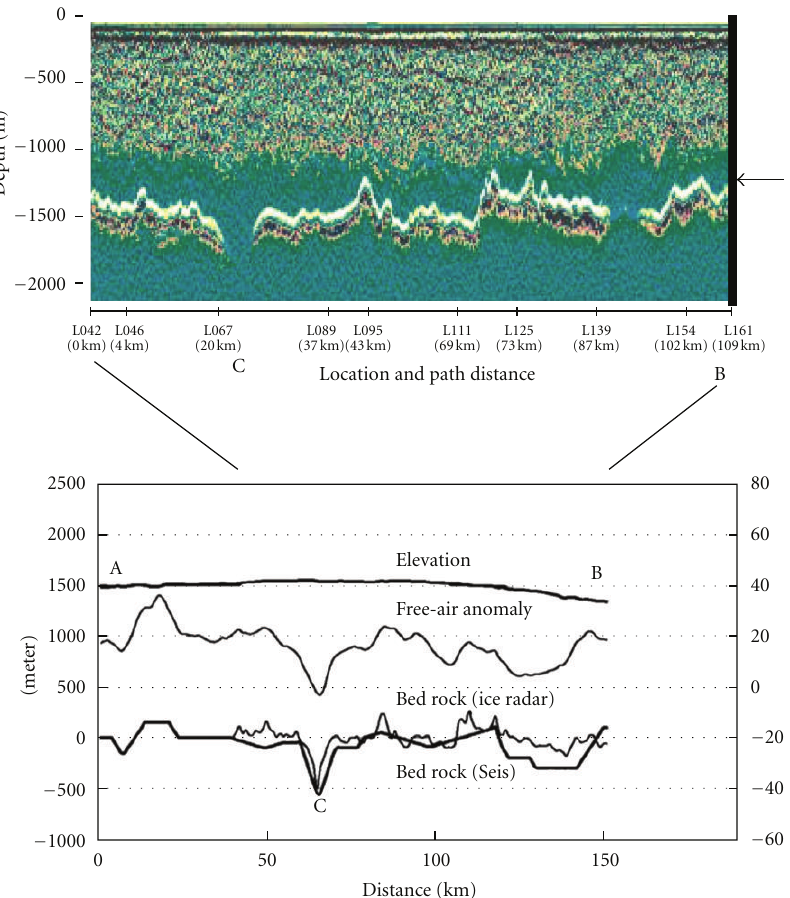
Figure 2: Comparison of several geophysical data measured along the SEAL-2002 profile (A-C-B) in Figure 1; (lower) elevation of the ice- sheet surface (scale on the left side), free-air gravity anomaly (scale on the right side, modified after [11]), depths of the bedrock inferred from radioecho soundings [13], together with those from seismic travel-time analysis [11]. (upper) detail result from ground-traverse based radioecho soundings between the stations (L042)-C-B (modified after [13]). Several refection layers of the inner ice-sheet together with strong reflections from bedrock are identified. It is also noticed that there are areas in the profile without any reflections from the bedrock (around C, and the area between L139 and L154). In the areas, there is a possibility of water-filled layer spreading over the bedrock surface just as the valley structure (see the text for